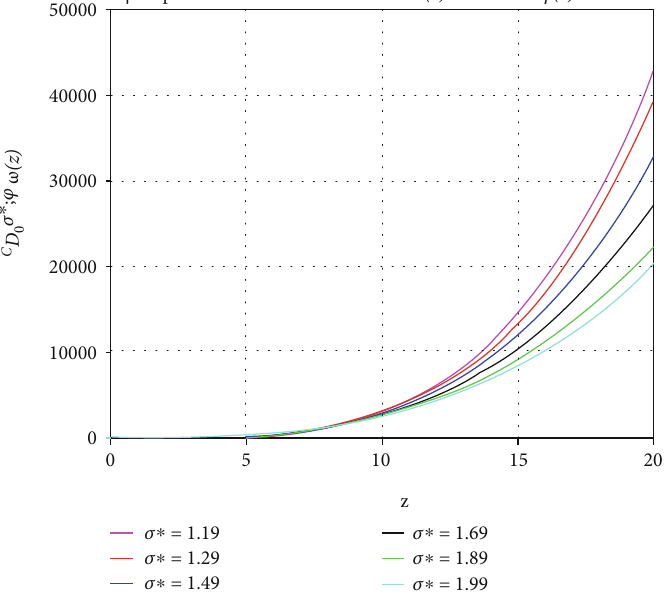
Figure 2: The CapFr-derivative of ϖ ð z Þ = z 5 /32 for φ ð z Þ = z /2